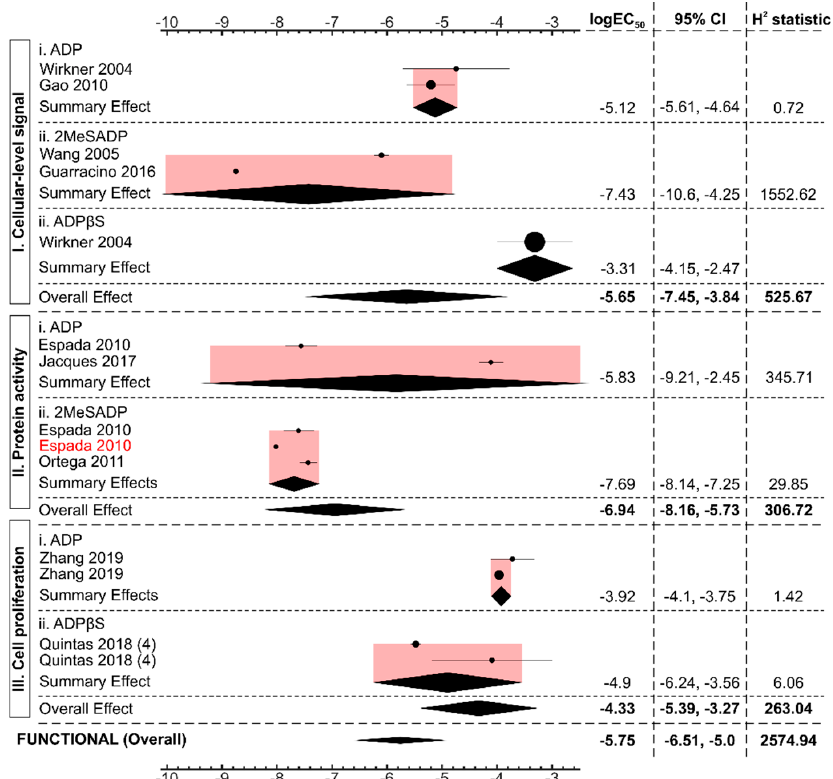
Figure 5. P2Y13-mediated functional responses with ADP and ADP-like agonists. Forest plot of log 10 EC 50 values of different ADP and ADP-like agonists to generate P2Y13-mediated functional outcomes. The black diamond represents the overall effect size, and the pink shaded region represents the 95% confidence interval. All studies were conducted in systems endogenously expressing the P2Y13 receptor with the exception of the dataset marked in “red” from the Espada et al. 2010 study, conducted in the heterologously-expressed P2Y13 receptor. All the studies were of sample size, n = 3, unless otherwise stated in parentheses.